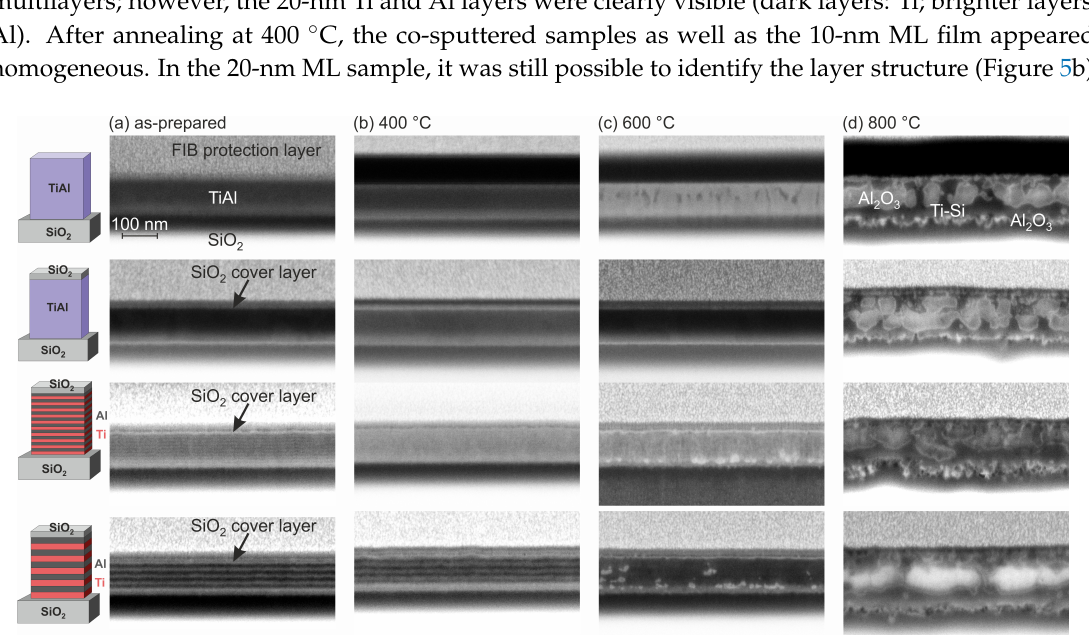
Figure 5. SEM images (inLens, 3 kV) of the FIB cross sections of the co-sputtered Ti-Al film, co-sputtered Ti-Al film with SiO 2 cover layer, and Ti/Al ML film with 10- and 20-nm individual layer thickness, both with SiO 2 cover layer in: ( a ) the as-prepared state; ( b ) after annealing at 400 ◦ C; ( c ) after annealing at 600 ◦ C; and ( d ) after annealing at 800 ◦